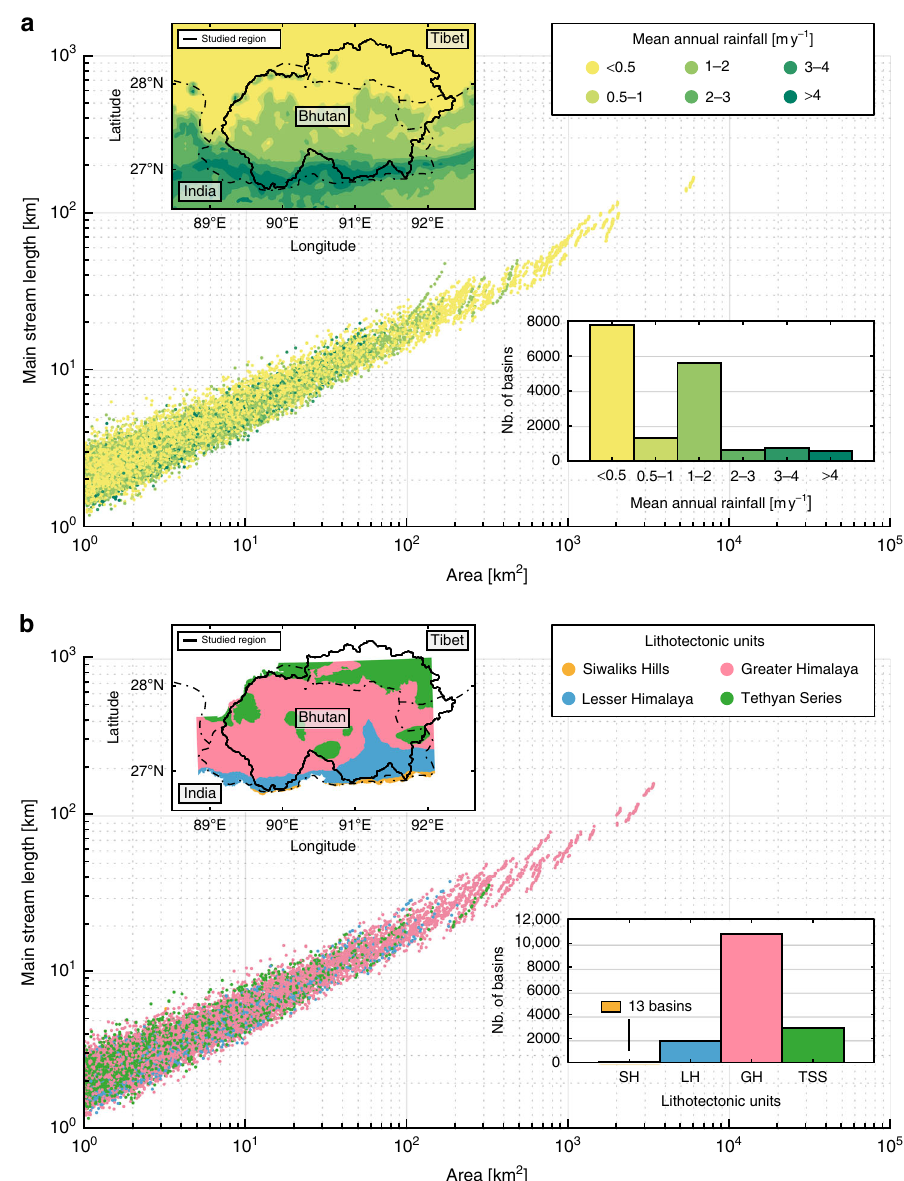
Fig. 6 Length – area relationship to mean annual rainfall and lithology. a Scatter plot of the main stream length with respect to the basin size. Colour scale indicates the annual rate of precipitation for each basin. Inserts are a map of the six main annual rainfall classes 16 and a histogram showing the distribution of basins with respect to these classes. b Scatter plot of the main stream length with respect to the basin size. Colour gives the geological domain for each basin. Inserts are a map of the four major litho-tectonic units in Bhutan 17 and a histogram showing the distribution of basins with respect to these